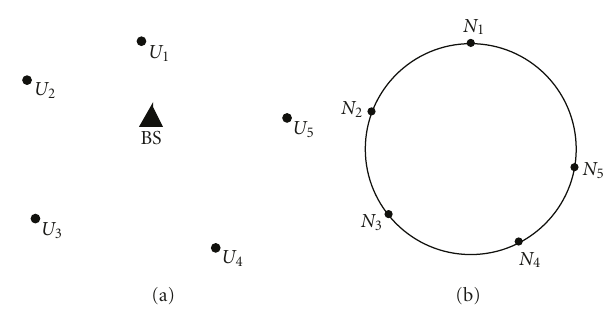
Figure 2: (a) User locations in a cell and (b) ring network con- structed from the user locations. Node N i in the ring corresponds to user U i